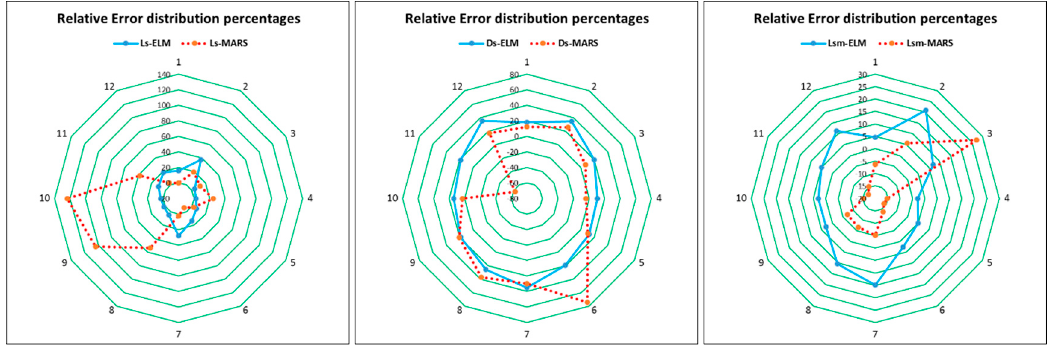
Figure 6. The relative error distribution percentages during validation of ELM and MARS models using dimensional variables.